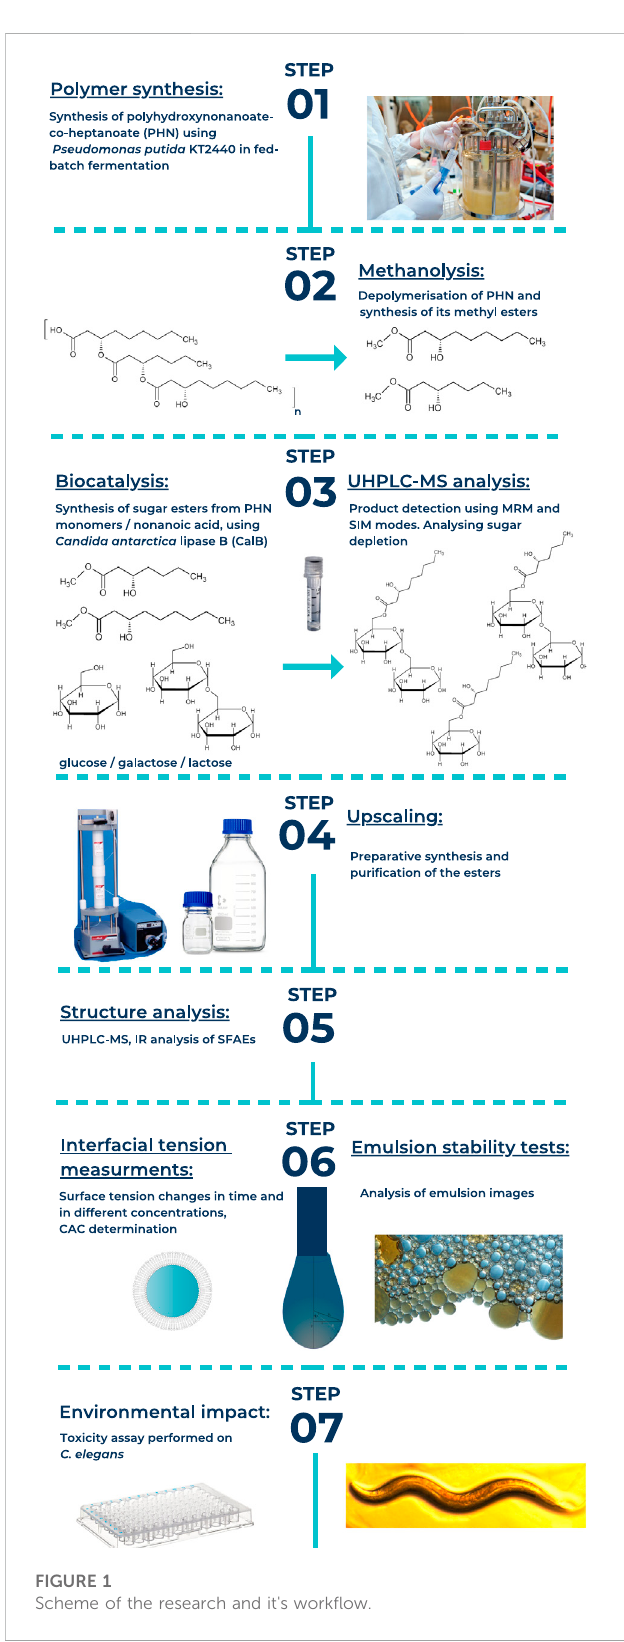
FIGURE 1 Scheme of the research and it's work fl